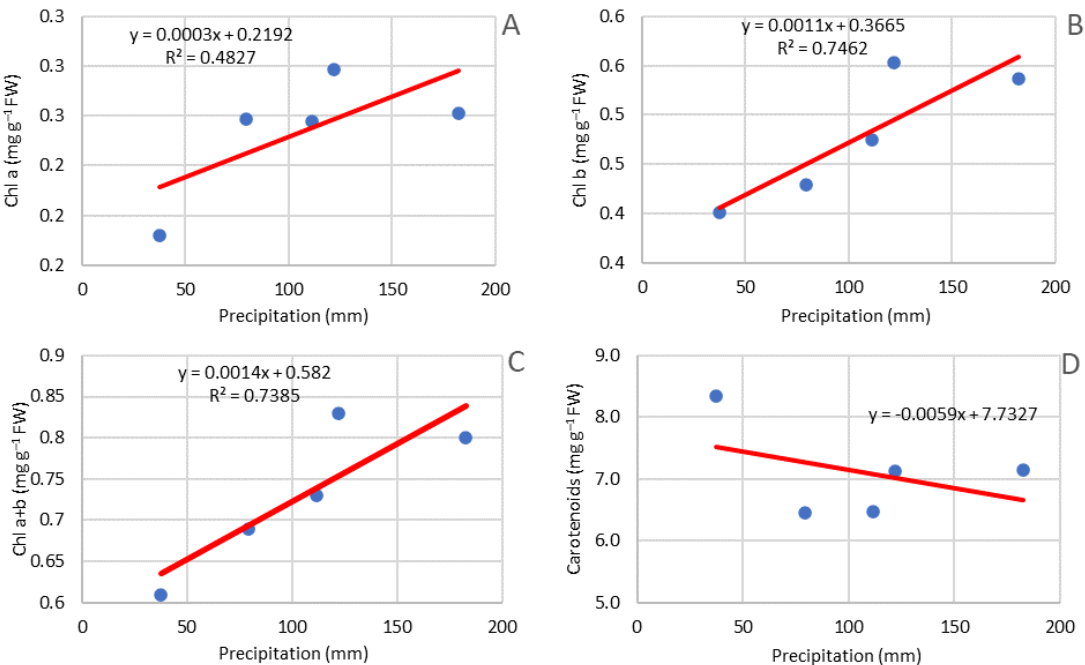
Figure 9. Effect of precipitation in July on the content of chlorophyll pigments. ( A )—chlorophyll a, ( B )—chlorophyll b, ( C )—chlorophyll a + b, ( D )—carotenoids.